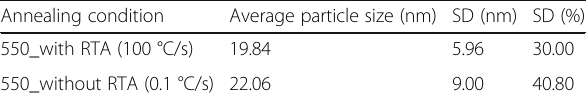
Table 2 The average particle size and standard deviation (SD) of Au nanoparticles annealed with RTA (100 °C/s) and without RTA (0.1 °C/s) through the in situ annealing